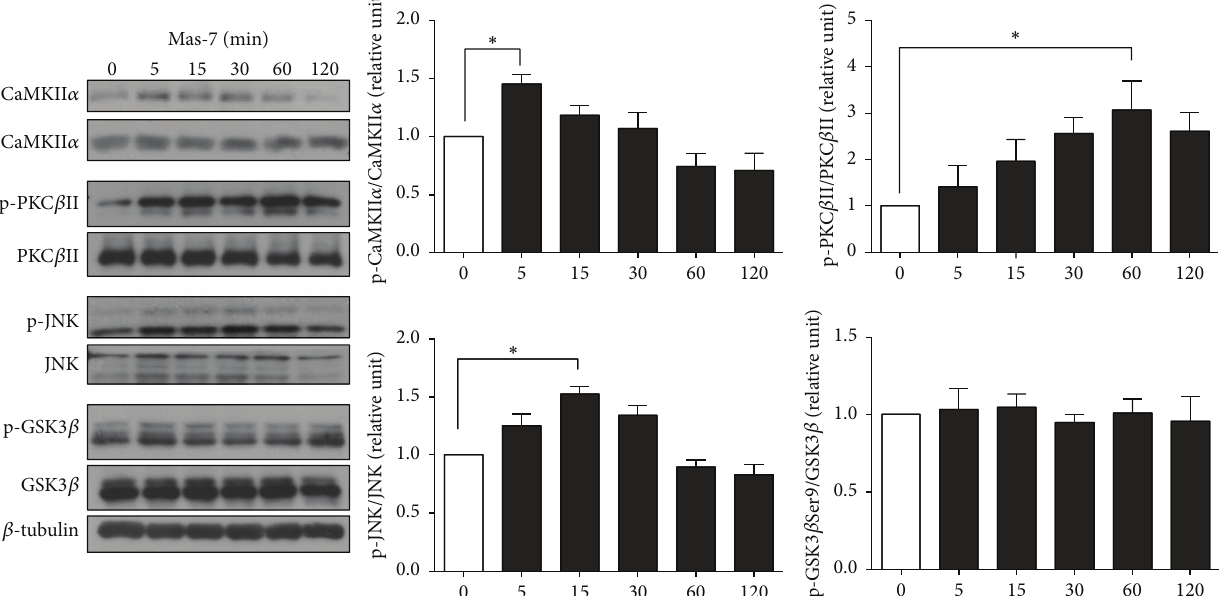
Figure 2: Mas-7 activates CaMKII, PKC, and JNK in hippocampal neurons. Representative western blot and quantification of total and phosphorylated levels of CaMKII 𝛼 ( 𝑛 = 4 ), PKC 𝛽 II ( 𝑛 = 4 ), JNK ( 𝑛 = 3 ), and GSK-3 𝛽 ( 𝑛 = 3 ) in 14 DIV hippocampal neurons incubated with 1 𝜇 M Mas-7 for different times. 𝛽 -tubulin was used as a loading control. ∗ 𝑝 < 0.05